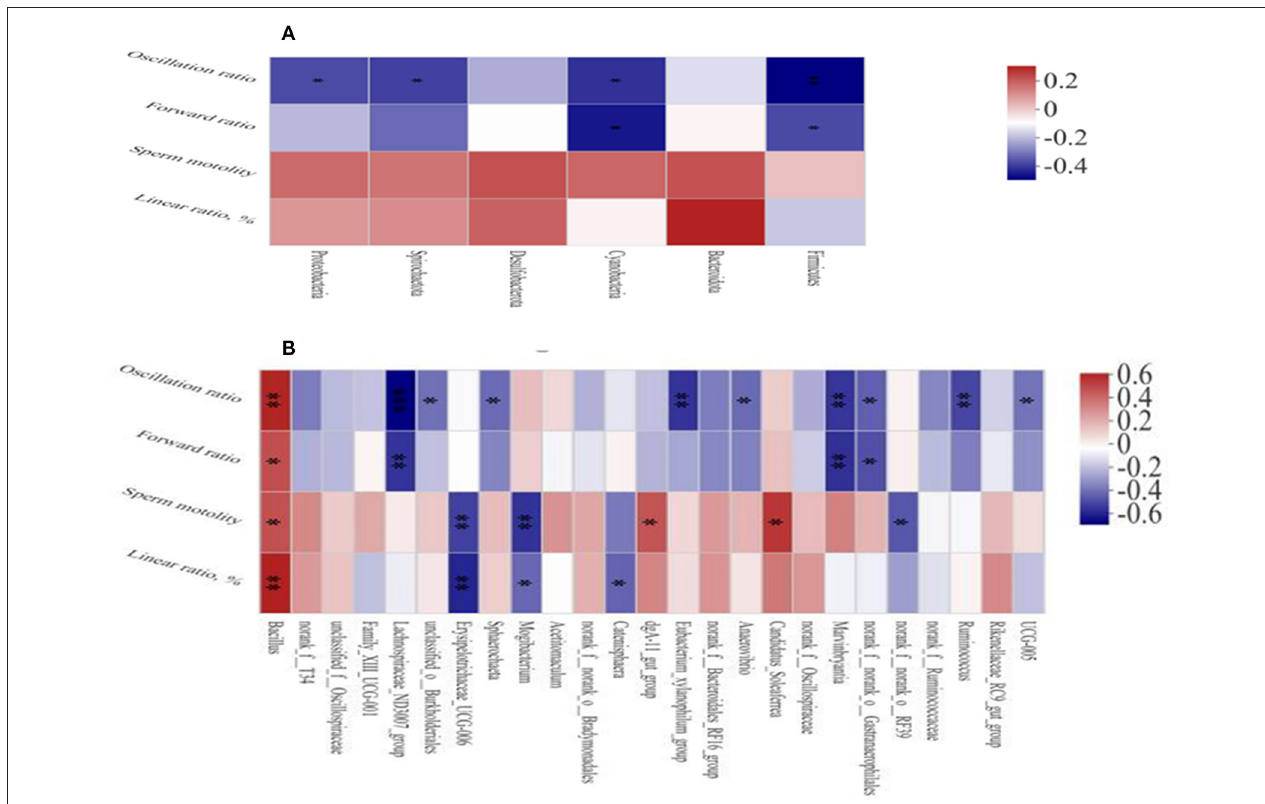
FIGURE 5 | Heat map of correlation analysis between sperm quality and intestinal microbiota at the phylum (A) and genus (B) level. Spearman’s diagram showed that the ordinate was environmental factor information and the abscess was species information. The value corresponding to the middle heat map was the Spearman’s correlation coefficient r, which was between − 1 and 1. r < 0 is negative correlation and r > 0 is positive correlation. * p < 0.05, ** p < 0.01, and *** p < 0.001.